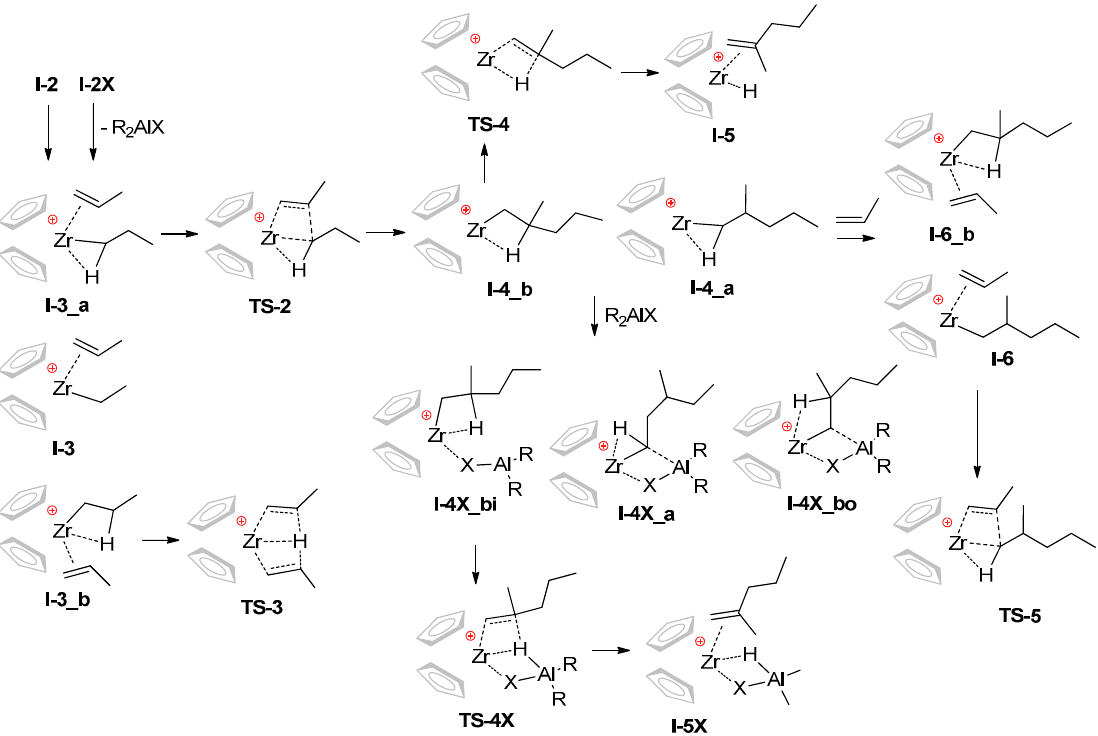
Figure 1. Calculated geometries of I-2H-bo complexes for ( a ) R = Me and ( b ) R = i Bu. The distances Zr-H are specified (Å).